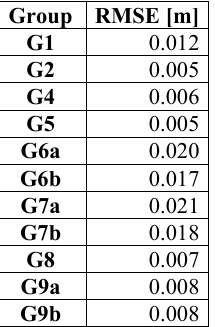
Table 2. C2C absolute distance evaluation.